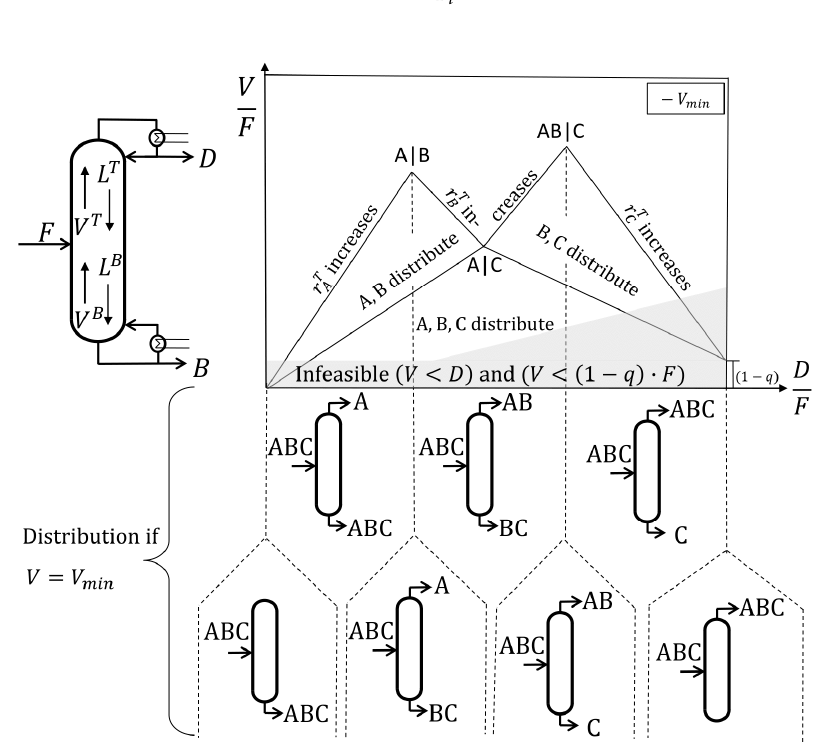
Figure 2. V min diagram for a ternary mixture, where component distributions in each region are shown for the case V = V min .